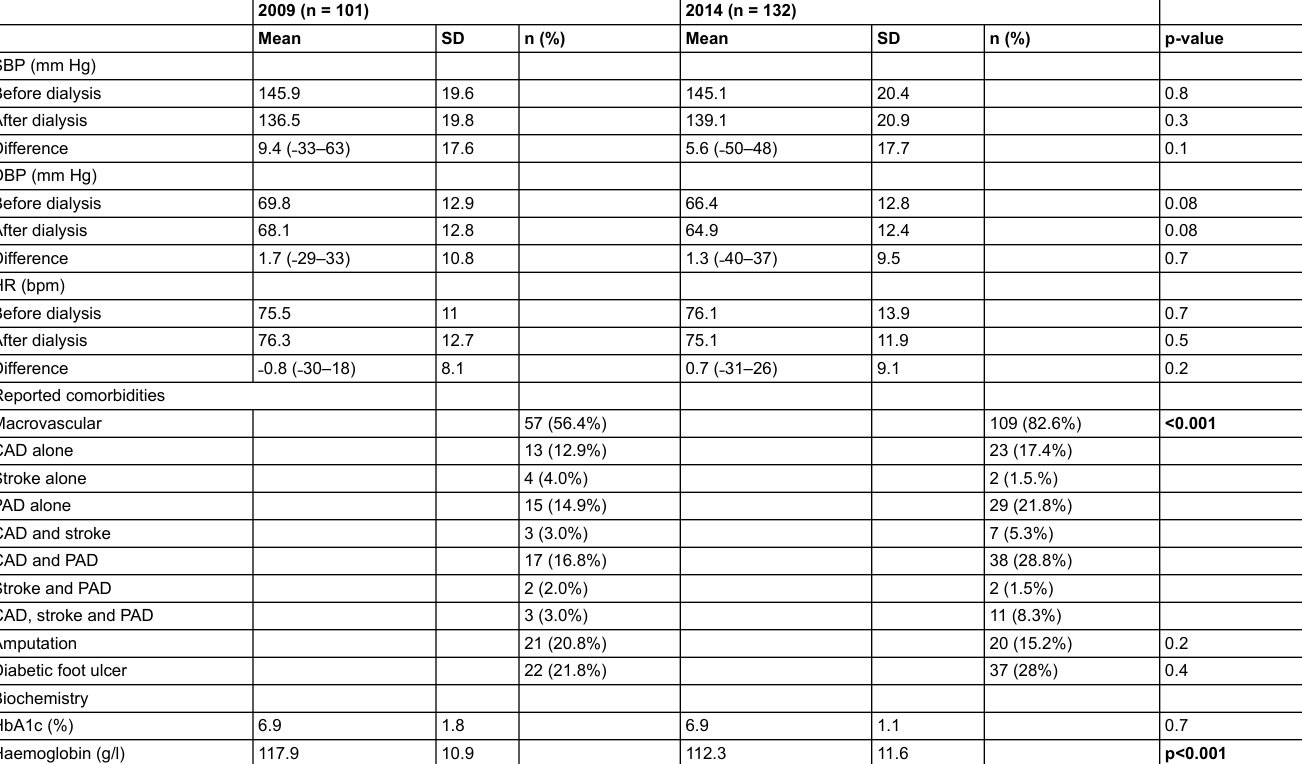
Table 2: Clinical characteristics of end-stage renal disease patients with diabetes in 2009 and 2014.